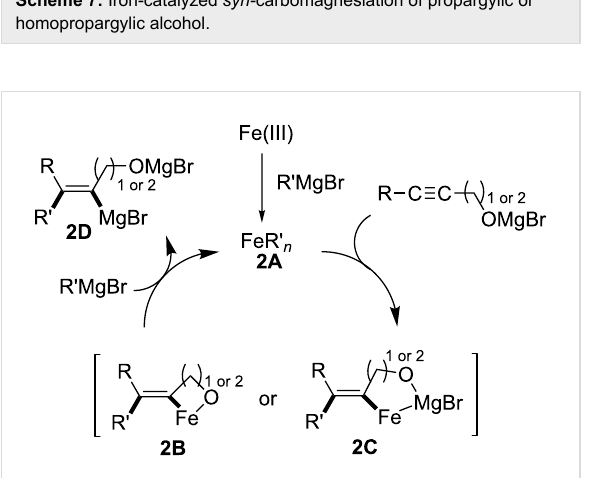
Scheme 8: Mechanism of iron-catalyzed